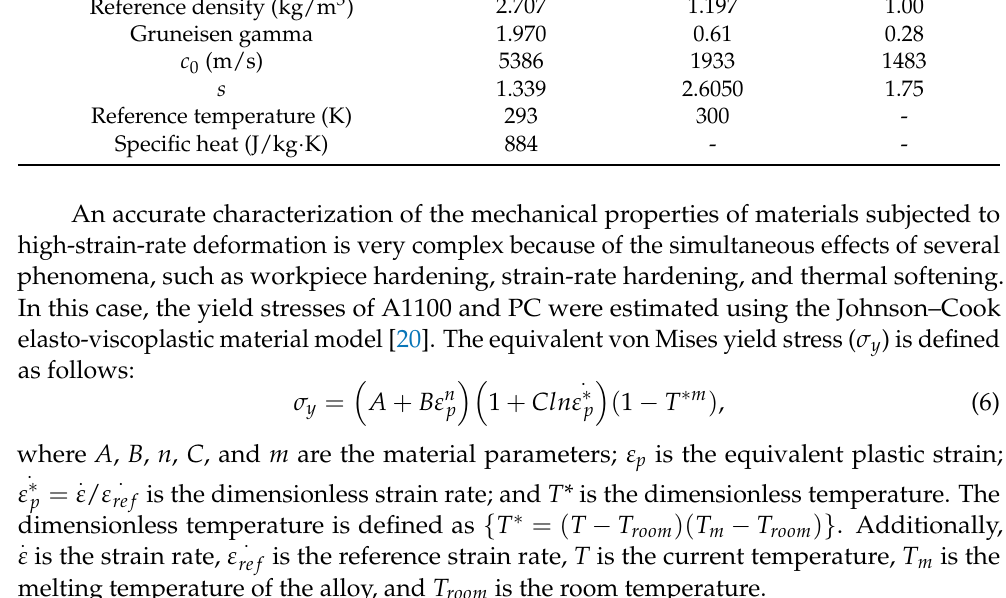
Table 2. Mie–Gruneisen EOS parameters for A1100 [17], PC [18] and water [19]. A1100